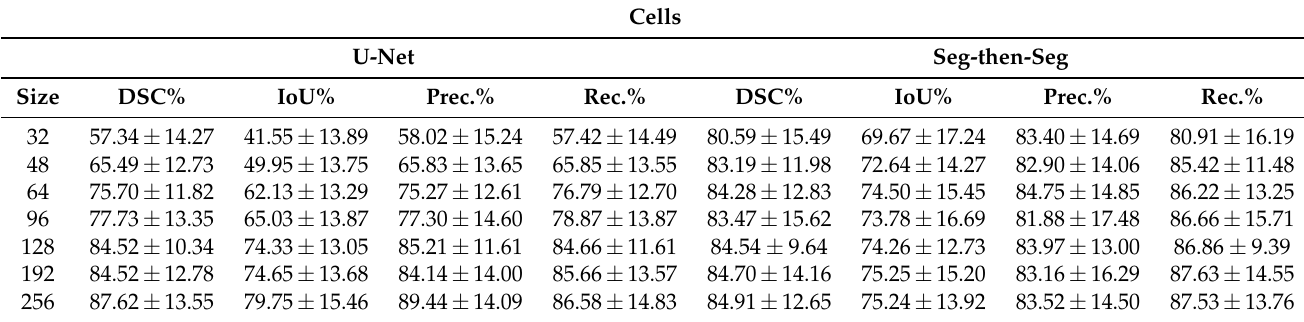
Table A1. The full results of each of our U-Net